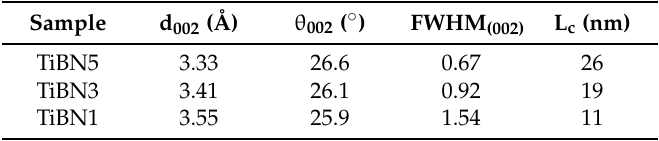
Table 3. Main XRD parameters of samples TiBN1, TiBN3 and TiBN5.